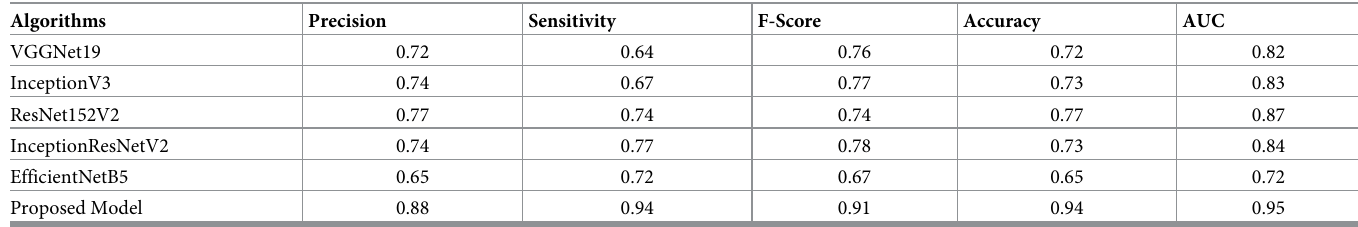
Table 4. Performance comparison of proposed model with pre-trained models on MIAS